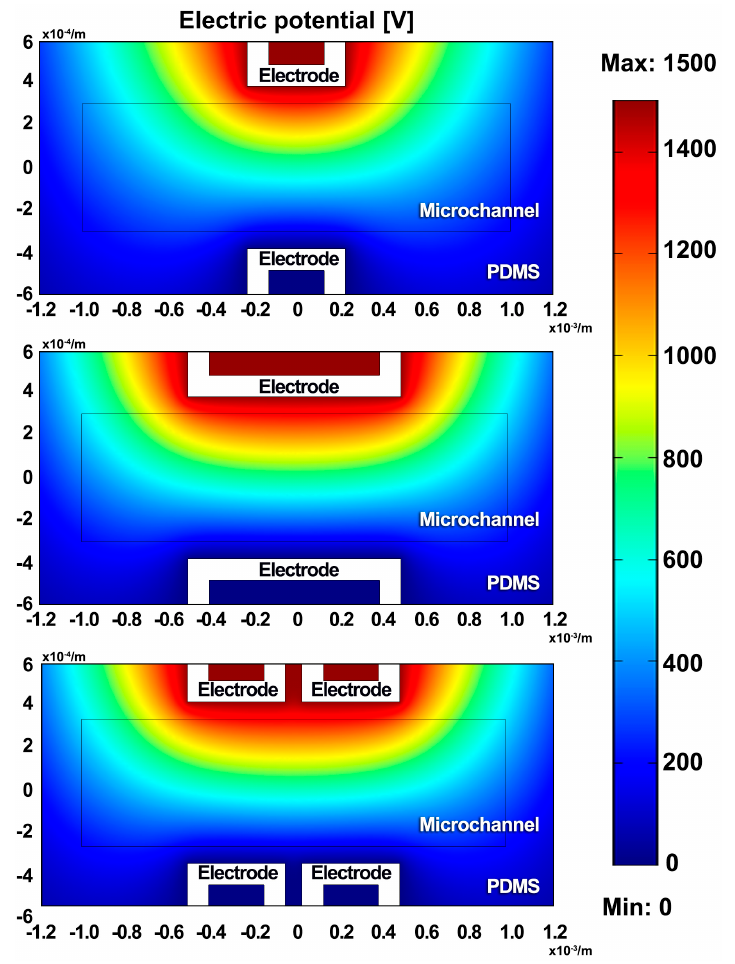
Figure 6. Numerical simulation of an electric potential of 1500 V applied to the upper electrodes of three designs.